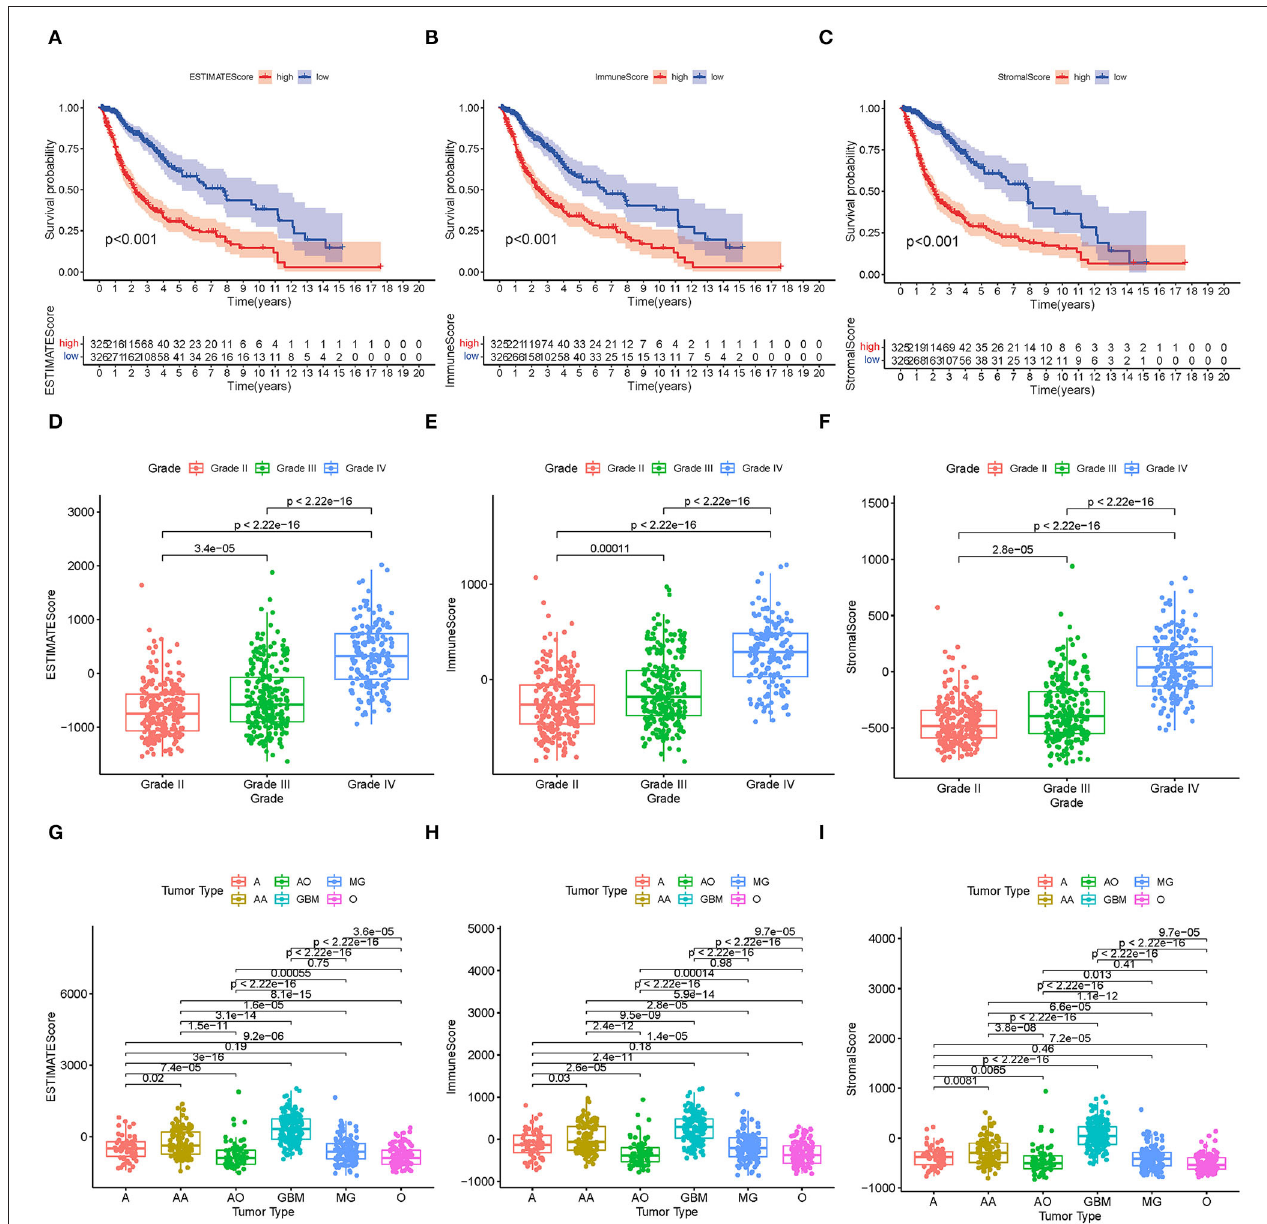
FIGURE 2 | Correlation between TME scores and survival and clinical characteristics. (A–C) KM survival analysis for glioma patients, grouped by low- and high-TME scores compared to the median. (D–F) Distribution of the ESTIMATE score, immune score, and stromal score by glioma grade. (G–I) Distribution of the ESTIMATE score, immune score, and stromal score by glioma